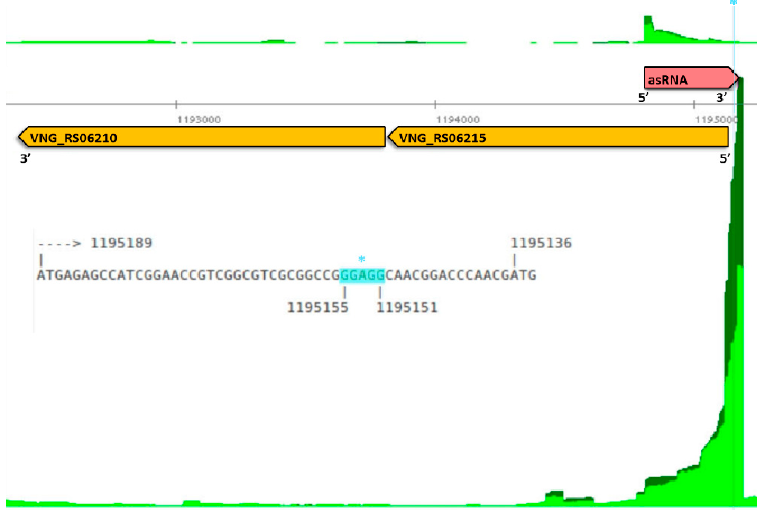
Figure 2. Antisense RNA in 5 ′ untranslated region (UTR). gcvP1 , encoding a glycine dehydrogenase subunit (VNG_RS06215). VNG_RS06215 locus (orange arrow) is in reverse strand (5 ′ → 3 ′ right to left), neighbor gene VNG_RS06210 (orange arrow) is also in reverse strand. Differential RNA-sequencing (dRNA-seq) read coverage signal is shown in dark and light green for TEX+ and TEX − libraries, respectively. Coverage signals below and above the central axis are for reverse and forward strands, respectively. VNG_as06215_888 asRNA (pink arrow) encompasses Shine–Dalgarno-like signature (* light blue highlight in genome coordinates and zoomed in sequence).